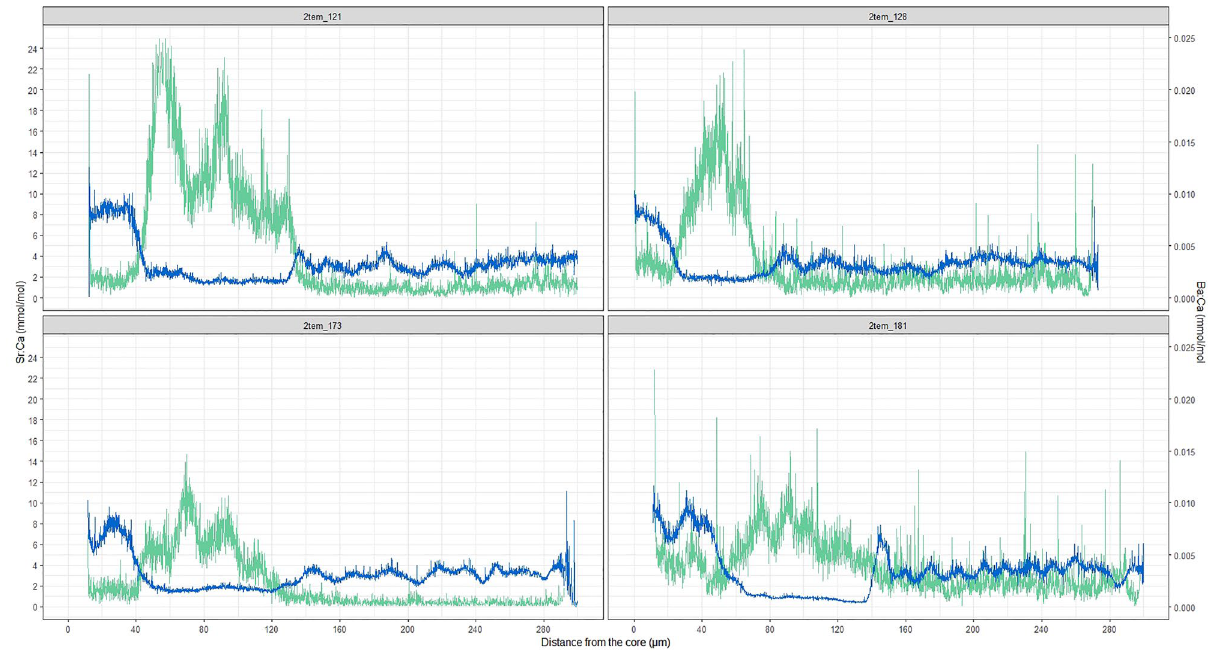
Figure 6. Otolith Sr:Ca (blue) and Ba:Ca (green) profiles of the four inter-habitat shifting eels ( Anguilla anguilla ) misclassified by the random forest analysis on blood